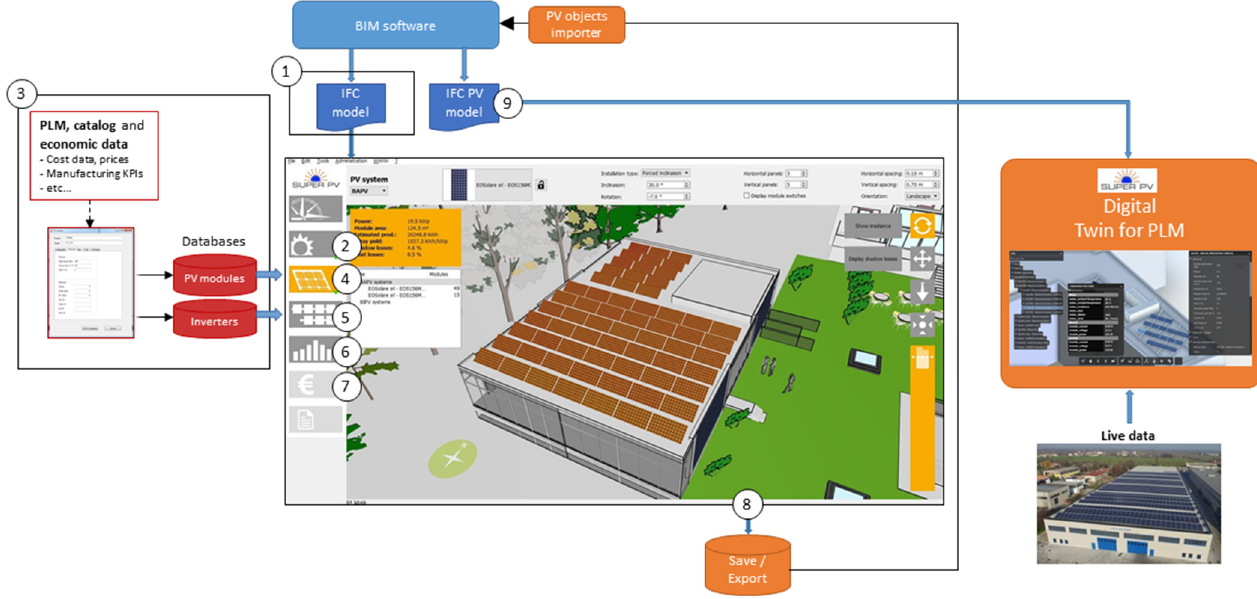
Fig. 3. SuperPV Platform: operative